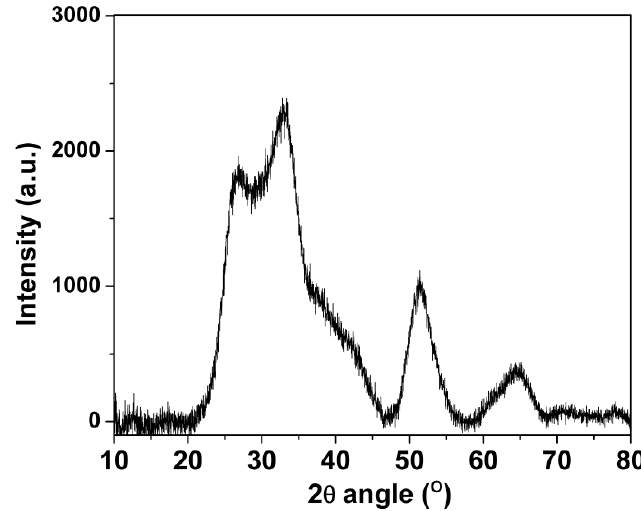
Figure 1. X-ray diffraction data for the SnO 2 -rGO composite synthesized in this work. Figure 1. X-ray di ff raction data for the SnO 2 -rGO composite synthesized in this